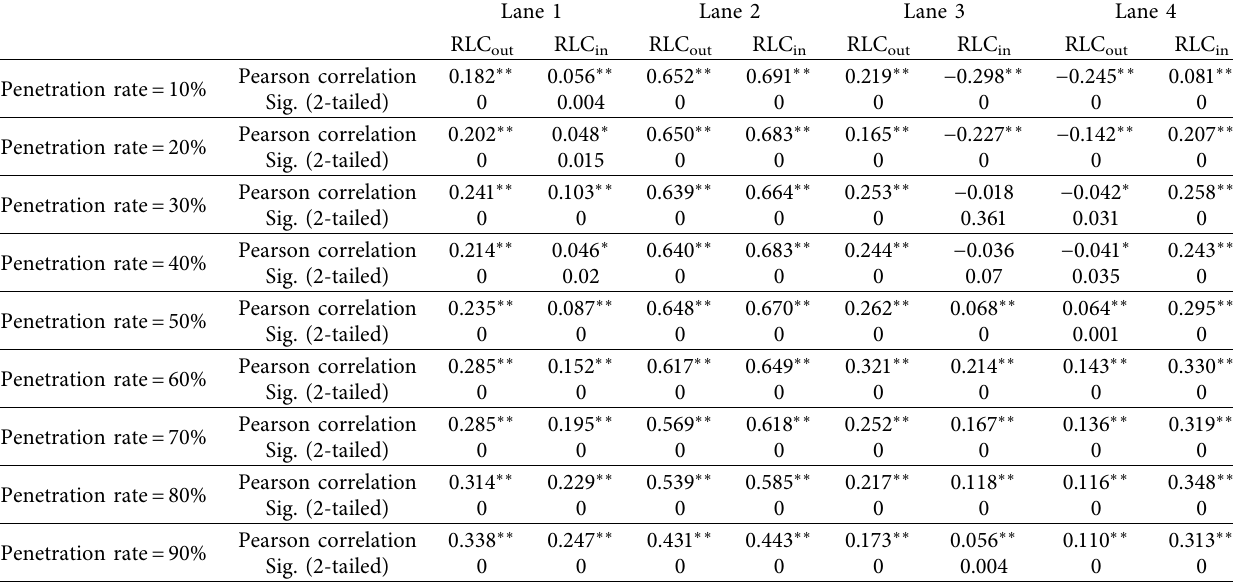
in ) and the rate of vehicles entering lane